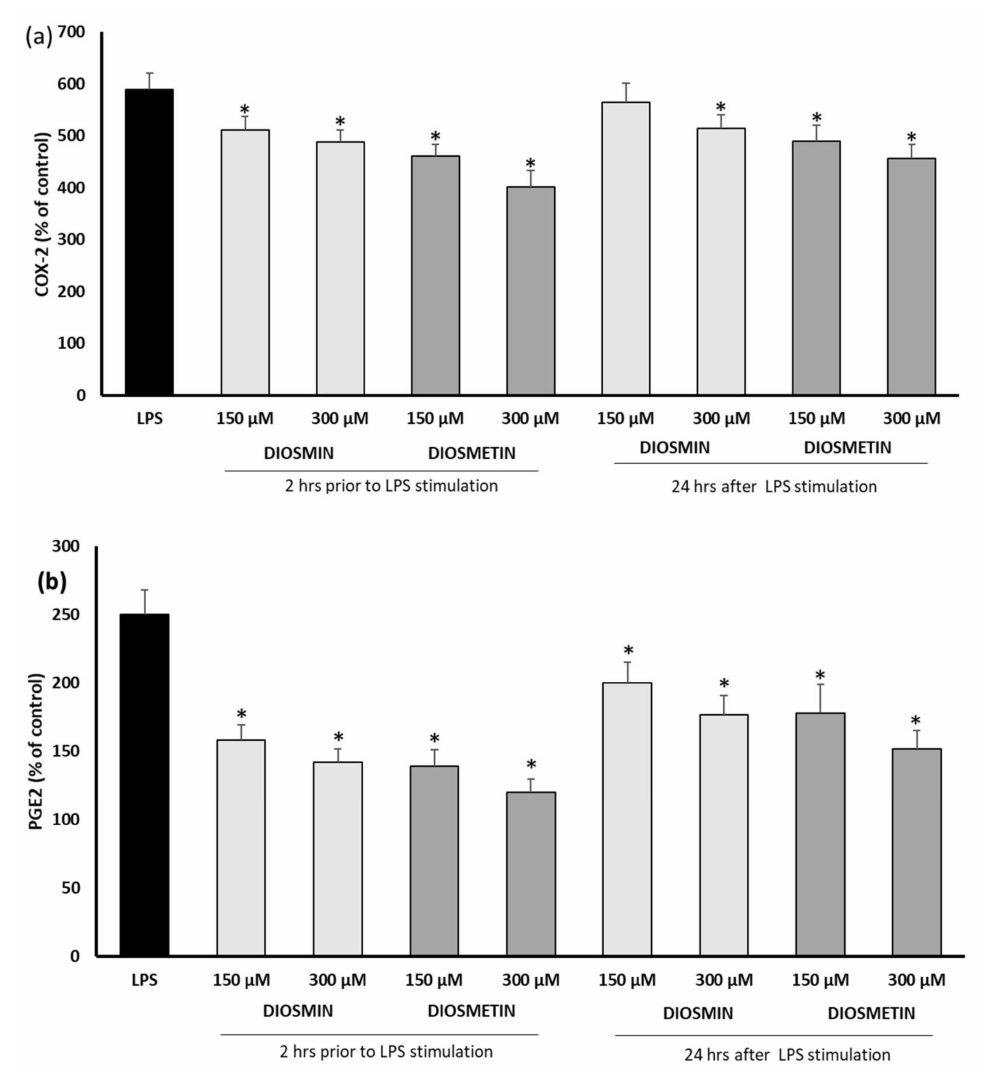
Figure 3. Effect of diosmin or diosmetin on COX-2 ( a ) and PGE-2 ( b ) in human fibroblast cells treated with LPS. Cells were treated with diosmin or diosmetin 2 h prior to or 24 h after LPS stimulation. The data are means ± SD ( n = 3). One-way ANOVA followed by Dunnett’s multiple compari- son post hoc test.; the differences were considered significant at p ≤ 0.05. * indicates statistically significant